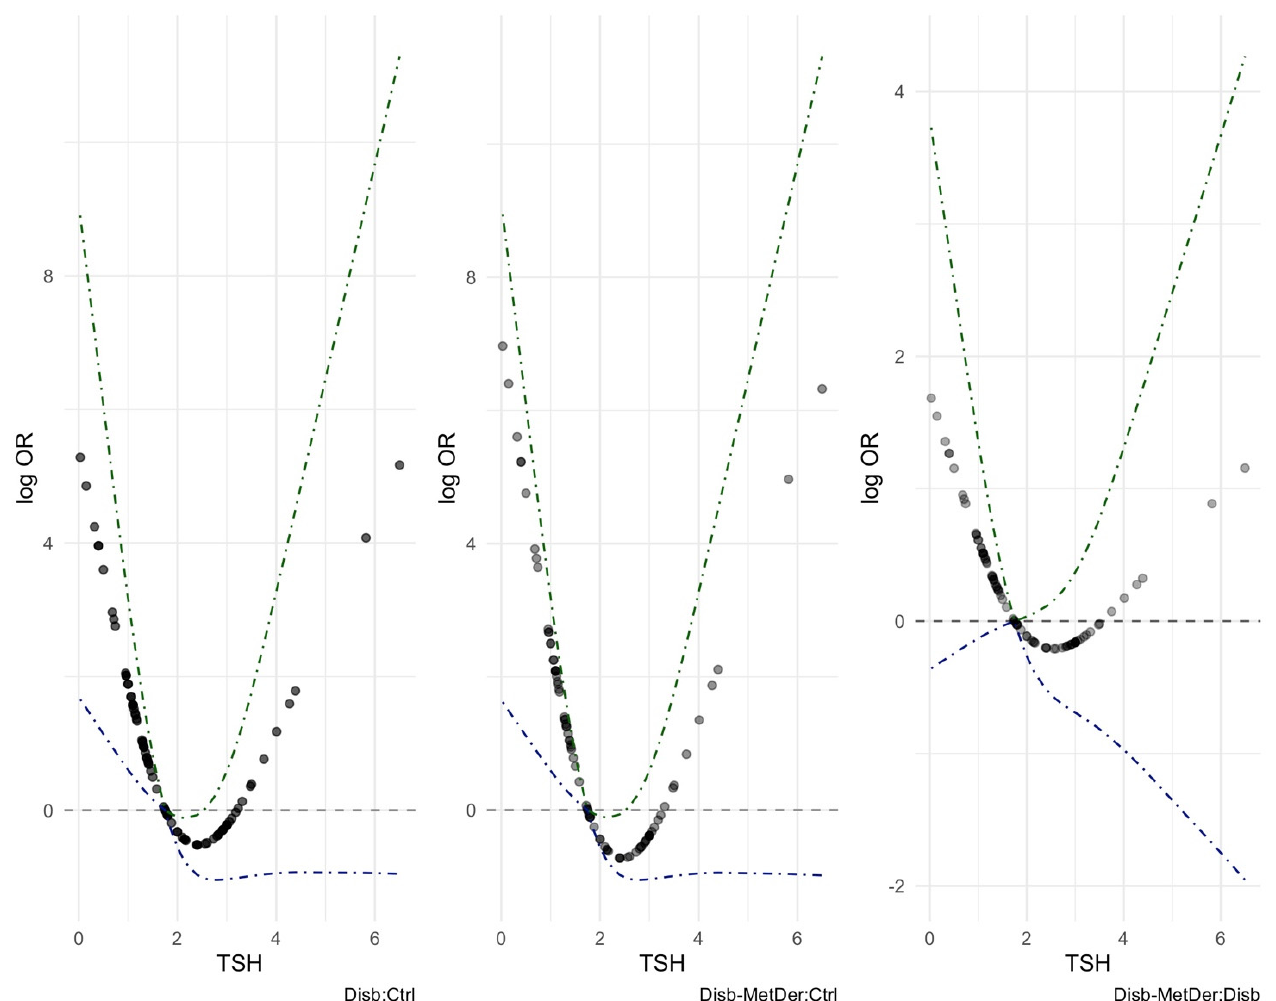
Figure A4. The figure shows the U-shaped statistically significant relationship between increasing values of TSH and the logarithmic form of the odds between the studied conditions found in the univariable multinomial logistic regression model.